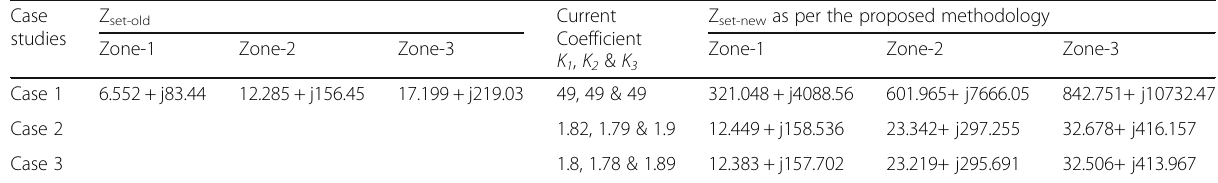
Table 2 Zone settings of the distance relays, R 12 , R 21 & R 23 using PAZSD methodology Case studies